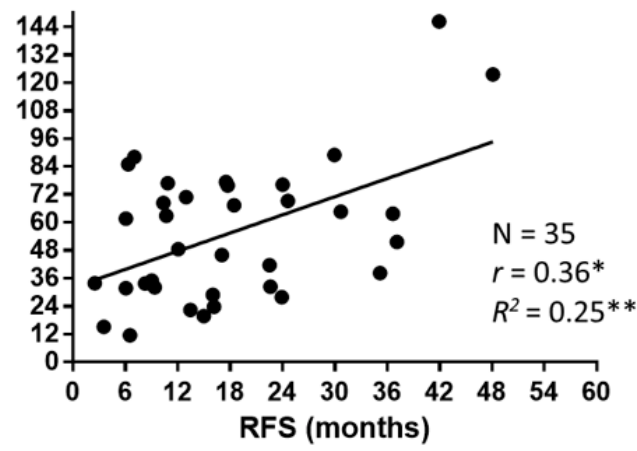
Figure 2. ( a ) Kaplan–Meier plot showing relapse-free survival (RFS). Median RFS: 16.0 months. ( b ) Kaplan–Meier plot showing overall survival (OS). Median OS: 70.9 months. 3.2. Correlations of RFS and PPS with OS